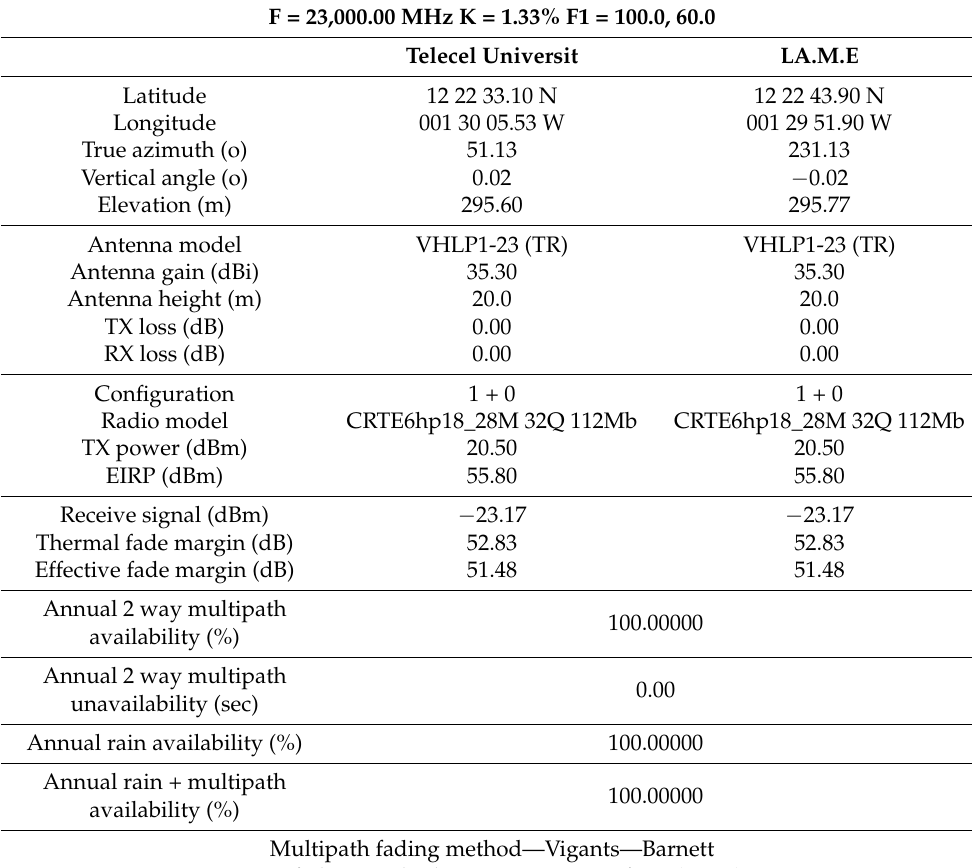
Table 1. Link budget detail report (Aviat Network, Inc. (July